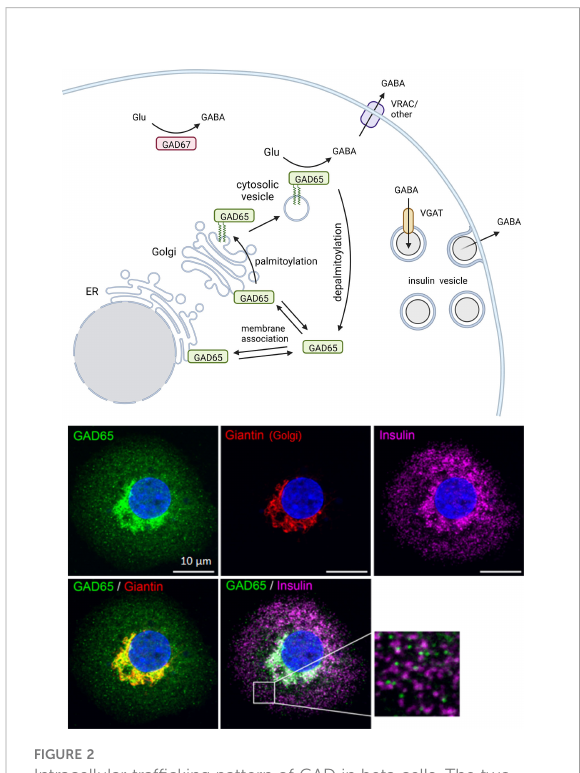
FIGURE 2 Intracellular traf fi cking pattern of GAD in beta cells. The two GABA-synthesizing enzymes, GAD65 and GAD67, are synthesized as cytosolic proteins. GAD65 becomes associated with the cytosolic face of ER and Golgi membranes and subsequently modi fi ed by double palmitoylation which allows forward traf fi cking onto post-Golgi intracellular vesicles. The palmitoylation step is reversible and serves to regulate localization of GABA synthesis between cytosolic and membrane-anchored pools of enzyme. GAD67 is the predominant isoform expressed in mouse beta cells while only GAD65 is expressed in human beta cells. In human beta cells GAD65 localizes to Golgi membranes and cytosolic vesicles that are distinct from insulin containing vesicles. Created with